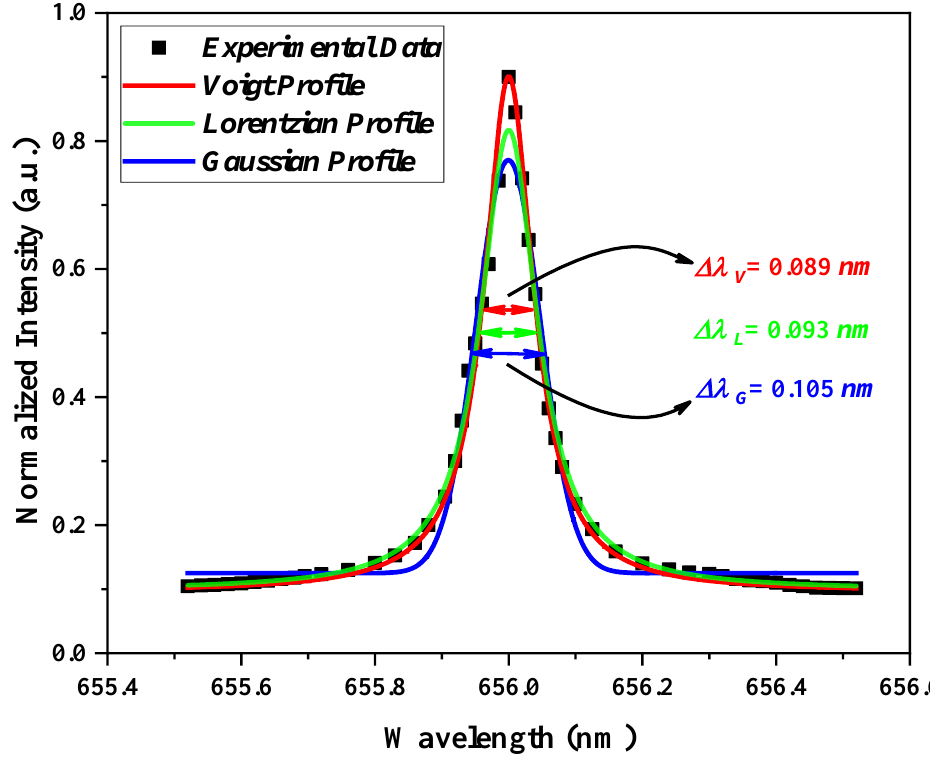
Figure 14. Comparison of the Voigt, Lorentzian, and Gaussian broadenings by fitting on experimental data.